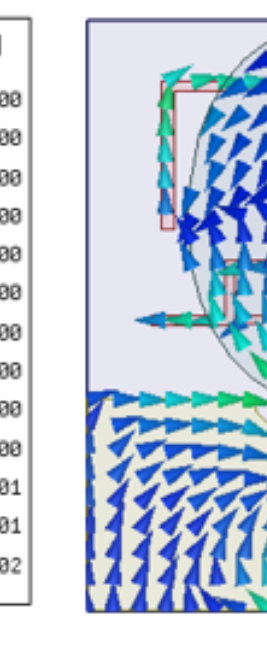
Figure 22. Current distribution at ( a ) 5.3 GHz and ( b ) 8.1 GHz.